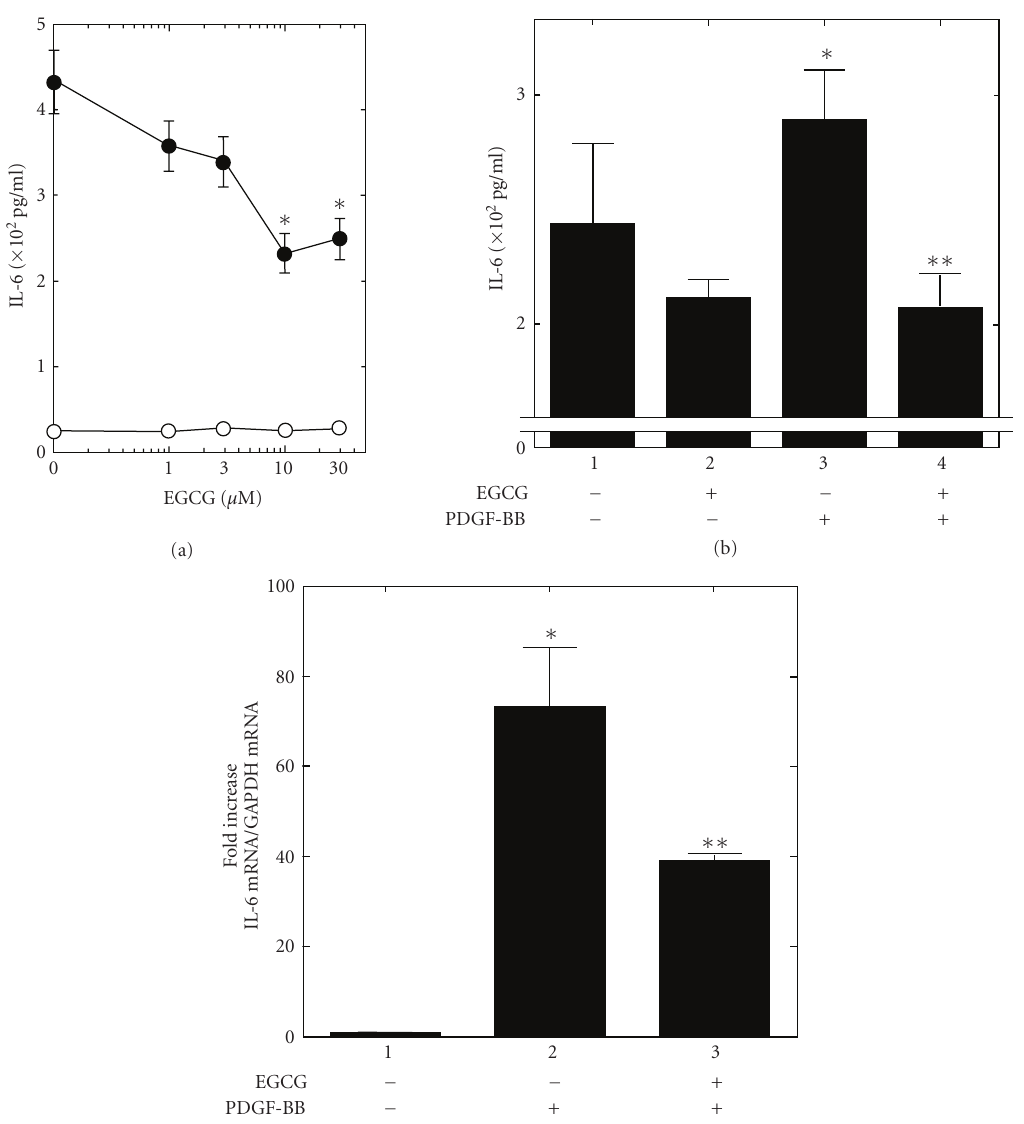
Figure 1: E ff ect of EGCG on the PDGF-BB-stimulated IL-6 synthesis and expression levels of IL-6 mRNA in osteoblasts. (a) Osteoblast-like MC3T3-E1 cells were pretreated with various doses of EGCG for 60 minutes, and then stimulated by 50ng/mL PDGF-BB or vehicle for 24 hours. Each value represents the mean ± SEM of triplicate determinations. Similar results were obtained with two additional and di ff erent cell preparations. ∗ P < . 05: compared to the value of control. ∗∗ P < . 05: compared to the value of PDGF-BB alone. (b) Primary cultures of osteoblast were pretreated with or without 30 μ M of EGCG for 60 minutes, and then stimulated by 50ng/mL PDGF-BB or vehicle for 24 hours. Each value represents the mean ± SEM of triplicate determinations. Similar results were obtained with two additional and di ff erent cell preparations. ∗ P < . 05: compared to value of the PDGF-BB alone. (c) Osteoblast-like MC3T3-E1 cells were pretreated with 30 μ M EGCG or vehicle for 60 minutes, and then stimulated by 50 ng/mL PDGF-BB for 60 minutes. Total RNA was isolated and transcribed into complementary DNA. The expressions of IL-6 mRNA and GAPDH mRNA were quantified by real-time RT-PCR. IL-6 mRNA levels were normalized with those of GAPDH mRNA. Results were standardized for the value of control (without EGCG and PDGF-BB). Each value represents the mean ± SEM of triplicate determinations. Similar results were obtained with two additional and di ff erent cell preparations. ∗ P < . 05: compared to the value of control. ∗∗ P < . 05: compared to the value of PDGF-BB alone.